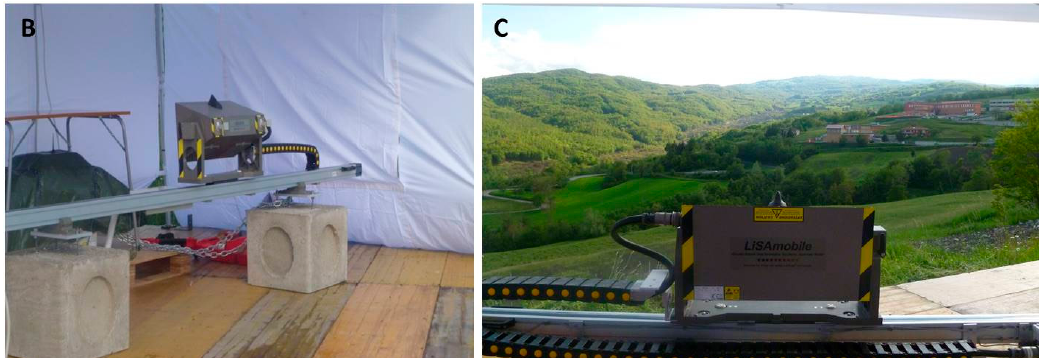
Figure 1 . ( A ) Location map of the Capriglio landslide and GB-InSAR (ground based interferometric synthetic aperture radar) system installation point; in yellow, the GB-InSAR detectable area is marked. Provincial roadways S.P. 101 (dashed white line) and S.P. 665R (dashed red line), including the Antria bridge are highlighted. ( B , C ) Employed GB-InSAR system.